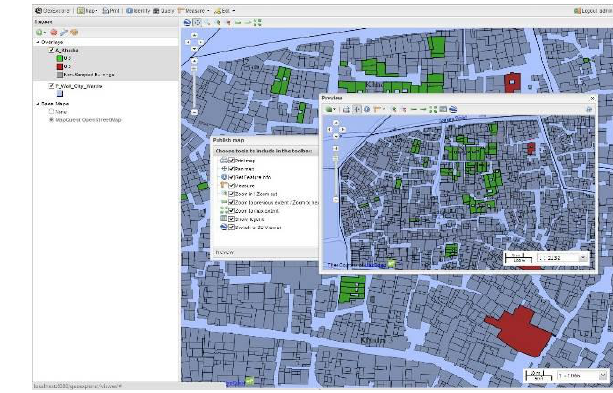
Figure 10. Info card for selected property Figure 11. Printing the query